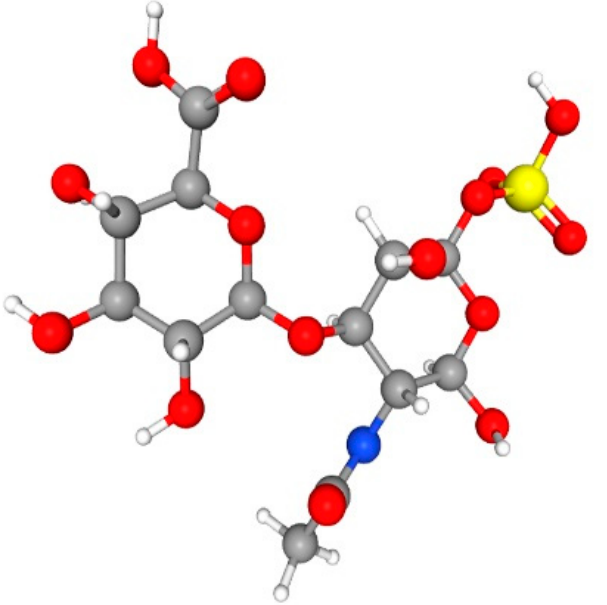
Figure 1. Chemical structure of Chondroitin sulphate. IUPAC name is (2 S ,3 S ,4 S ,5 R ,6 R )-6-[(2 R ,3 R ,4 R ,5 R ,6 R )-3-acetamido-2,5-dihydroxy-6-sulfooxyoxan-4-yl]oxy-3,4,5-trihydroxyoxane-2-carboxylic acid. The white stick shows a hydrogen bond, the ash ball shows carbon, the red ball shows O-linkage, the yellow ball shows the sulphate group, and the blue ball shows the amino group. This structure was retrieved from pubchem.ncbi.nlm.nih.gov (accessed on 2 November 2021).